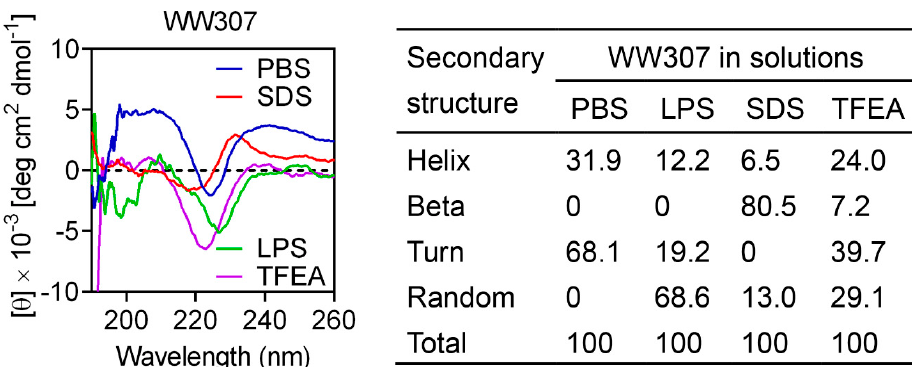
Figure 4. Circular dichroism (CD) spectra of WW307 in various solutions. PBS (10 mM, pH = 7.4), lipopolysaccharide (LPS) (50 μ M), sodium dodecyl sulfate (SDS) (50 mM), and 50% TFEA were used. The values from three scans were averaged per sample, and the peptide concentrations were fixed at 100 μ g/mL.